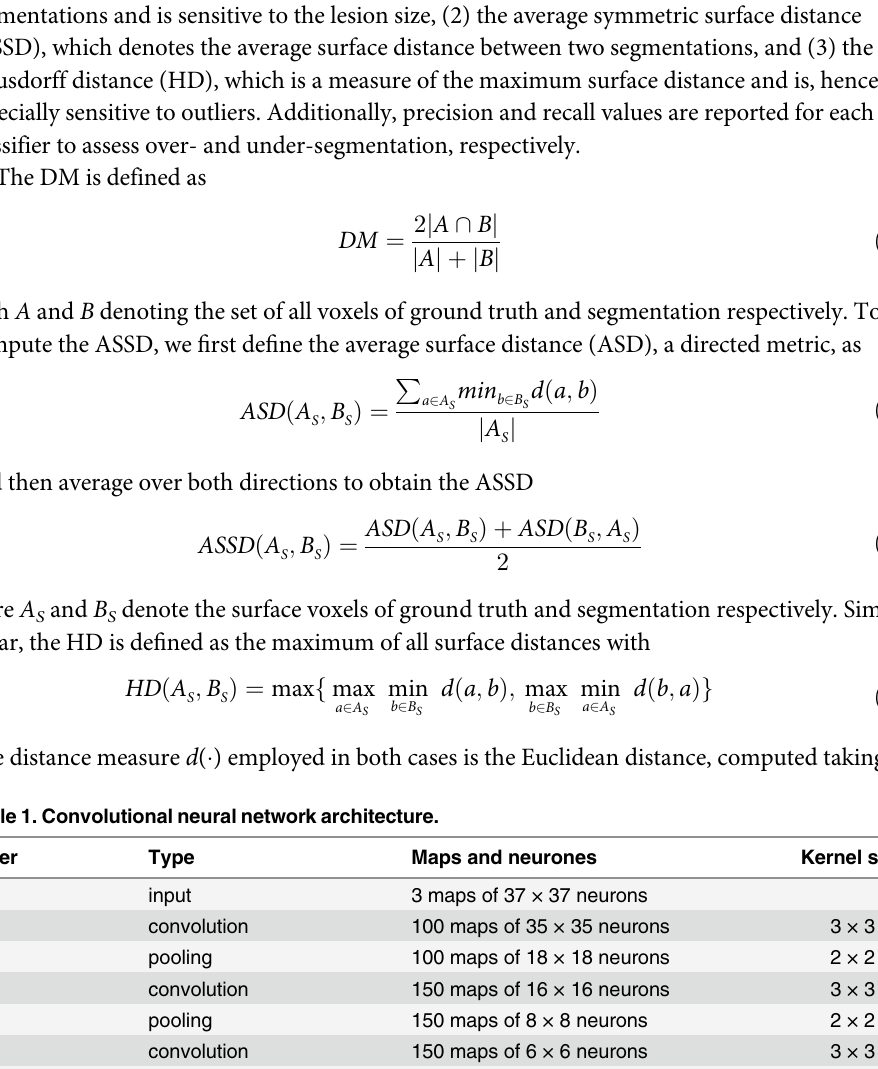
Table 1. Convolutional neural network architecture. Layer Type Maps and neurones Kernel size 0 input 3 maps of 37 × 37 neurons 1 convolution 100 maps of 35 × 35 neurons 3 × 3 2 pooling 100 maps of 18 × 18 neurons 2 × 2 3 convolution 150 maps of 16 × 16 neurons 3 × 3 4 pooling 150 maps of 8 × 8 neurons 2 × 2 5 convolution 150 maps of 6 × 6 neurons 3 × 3 6 pooling 150 maps of 3 × 3 neurons 2 × 2 7 fully connected 300 neurons 1 × 1 8 fully connected 2 neurons 1 × 1 The input is processed from the top to the bottom, where the two output neurons each represent one class. Recti fi ed linear activation is used after each convolution and the fi rst fully connected layer. The two fi nal neurons are activated by a softmax function and can be interpreted as the probability of a particular input to belong to the respective